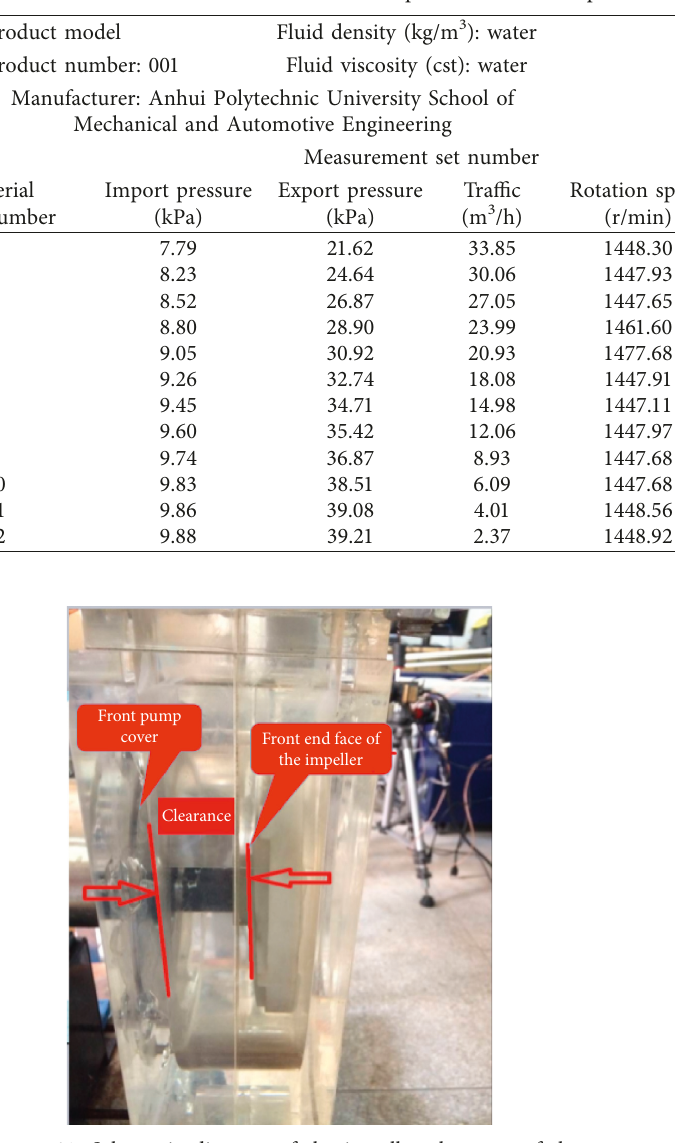
Table 17: Experimental table of performance of lining plastic pump.